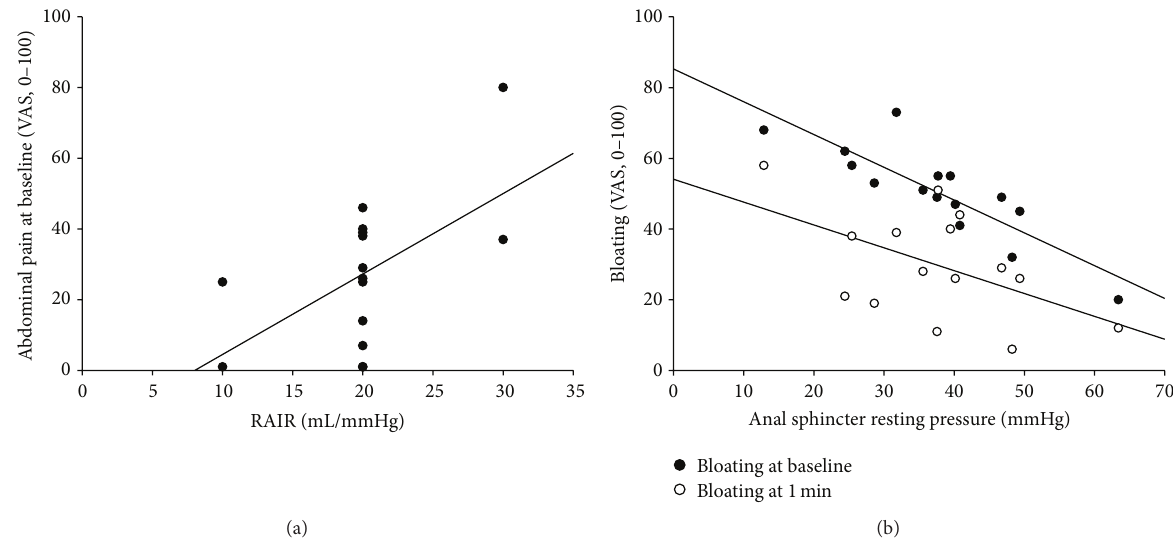
Figure3:Associationbetweenabdominalsymptomsandanorectalmanometryaftershamtubetreatment.Baselineabdominalpaincorrelates positively with RAIR ( 𝑟 = 0.57 , 𝑃 = 0.03 ) (a). Anal resting pressure correlates negatively with baseline bloating ( 𝑟 = −0.85 , 𝑃 < 0.001 ) and